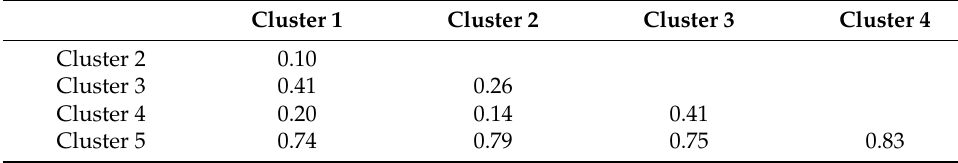
Table 5. Pairwise Fst between populations suggested by